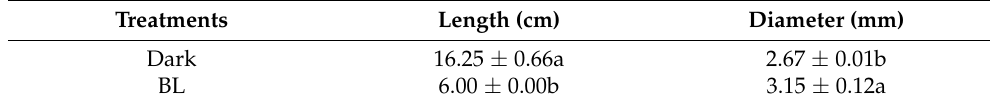
Table 1. Effects of blue light on hypocotyl length and